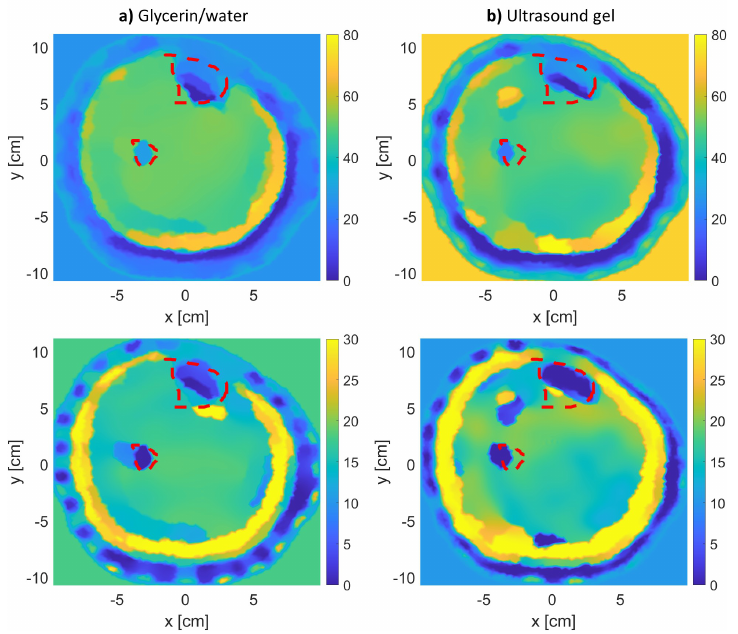
Figure 5. The real ( top row ) and imaginary ( bottom row ) relative complex permittivity results for leg model 2: ( a ) using glycerin/water matching medium, and ( b ) using the ultrasound gel matching medium. The red-dotted lines indicate the bones’ actual locations.